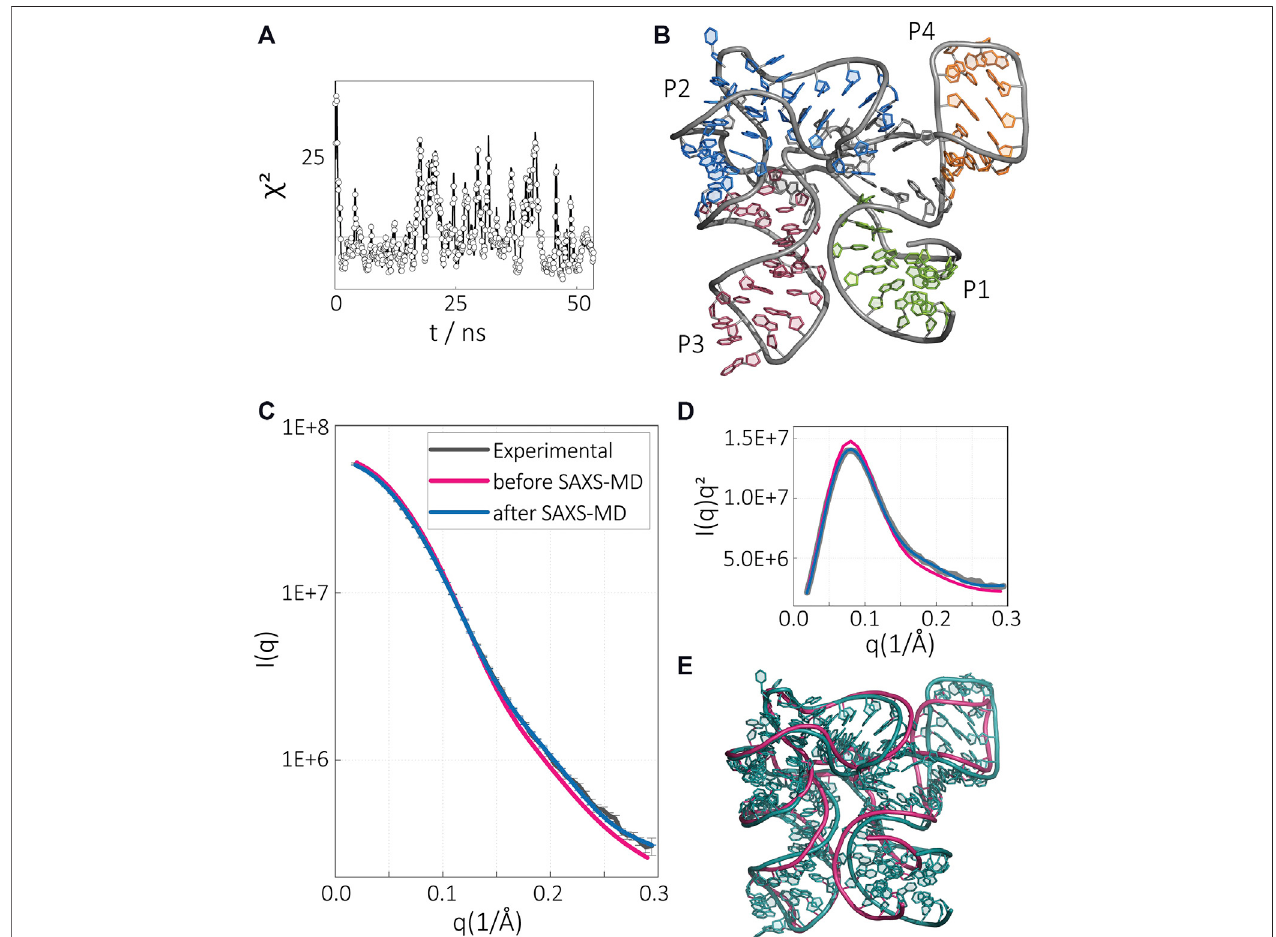
FIGURE 3 | SAM-I riboswitch aptamer in the presence of SAM and Mg 2+ . (A) Time evolution of χ 2 variable during SAXS-driven MD simulation. (B) Converged structureafterSAXS-drivenMDsimulationwithexperimentaldatafortheMg 2+ -andSAM-boundaptamerstate.Intensityinthe (C) normaland (D) Kratkyrepresentation. The experimental SAXS data (gray), computed SAXS data of the crystal structure (magenta), and computed SAXS data of the SAXS-driven MD fi nal structure (blue). (E) Comparison of the SAXS-driven MD structure (blue) with the crystal structure